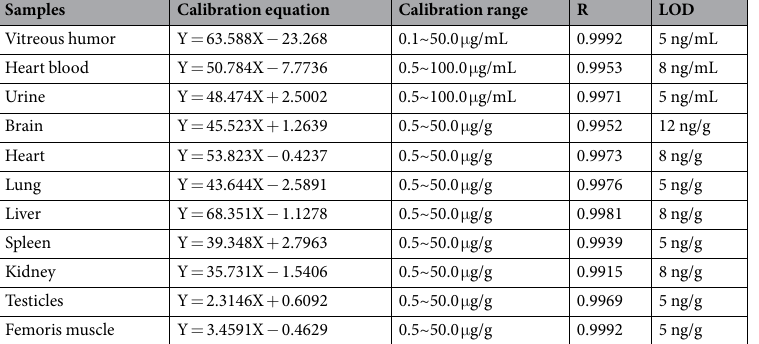
Table 3. Calibration Equations and LOD of MDMA in Samples (n = 6). Y stands for the peaks area ratio of MDMA and SKF 525A ; X stands for concentration of MDMA ( μ g/mL and μ